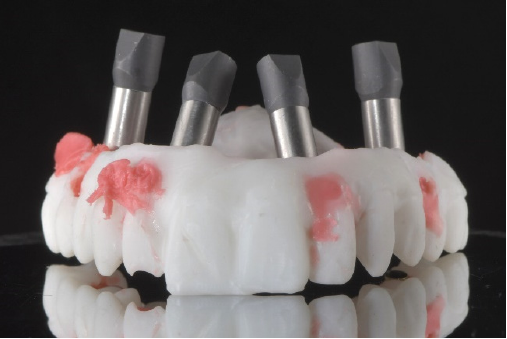
Figure 21. Scan analogs connected to the temporary abutments.